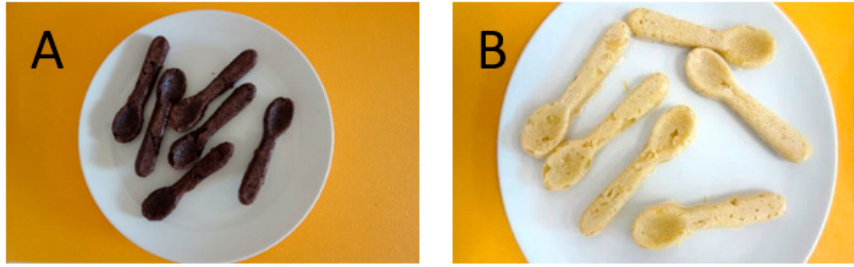
Figure 1. The examples of biodegradable spoons with ( A ) and without ( B ) grape seed flour.